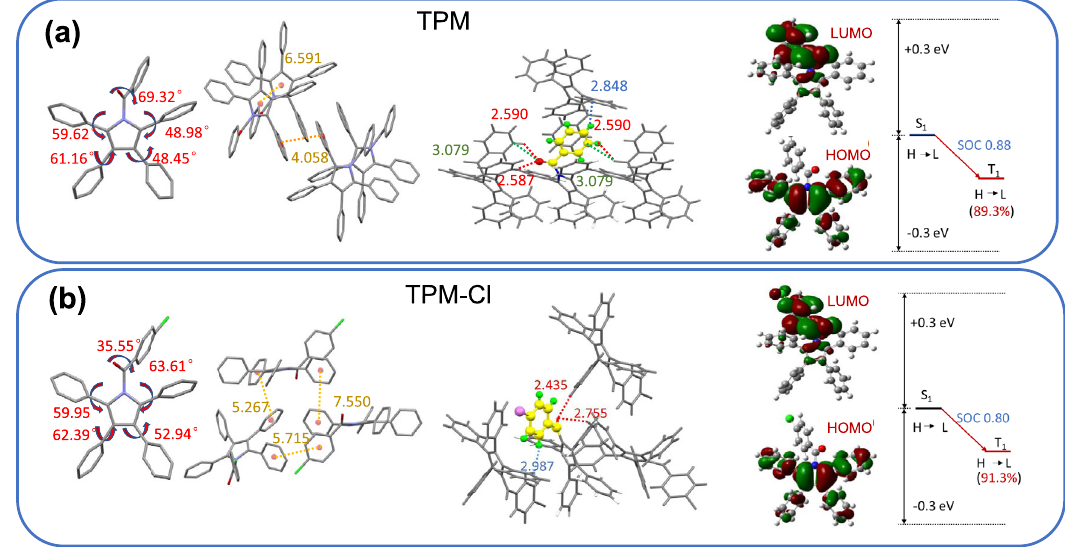
Fig. 3 Single-crystal analysis and theoretical calculations. Molecular conformations, intermolecular interactions, and molecular orbitals of the a TPM and b TPM-Cl crystals. Intermolecular interactions: aromatic ring interactions (orange lines), C-H··· π (blue lines), C-H···O (red lines), and C-O··· π (green lines). LUMO: lowest unoccupied molecular orbital, HOMO: highest occupied molecular orbital, SOC: spin – orbital